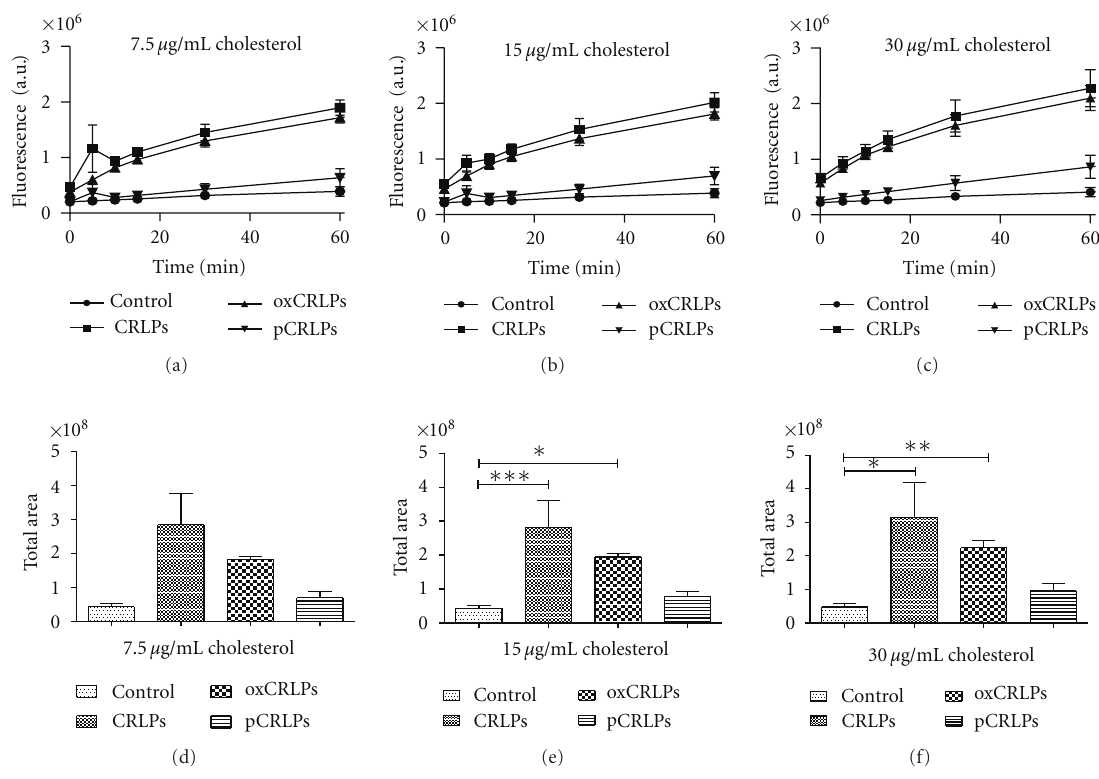
Figure 2: Generation of reactive oxygen species after coculture of CRLP with primary human blood monocytes. Monocytes were preloaded with dihydrorhodamine 1, 2, 3 before incubation with CRLPs, oxCRLPs, or pCRLPs and measurement of fluorescence (ROS production) at increasing timepoints. (a, b, c) Time course of ROS production (fluorescence) 7.5 μ g/mL, 15 μ g/mL and 30 μ g/mL cholesterol, respectively. (d, e, f) area under curve analysis (Prism) 7.5 μ g/mL, 15 μ g/mL and 30 μ g/mL cholesterol respectively. n = 5 monocyte isolations. ∗ P < 0 . 05, ∗∗ P < 0 . 01, ∗∗∗ P < 0 . 001 paired t- test.